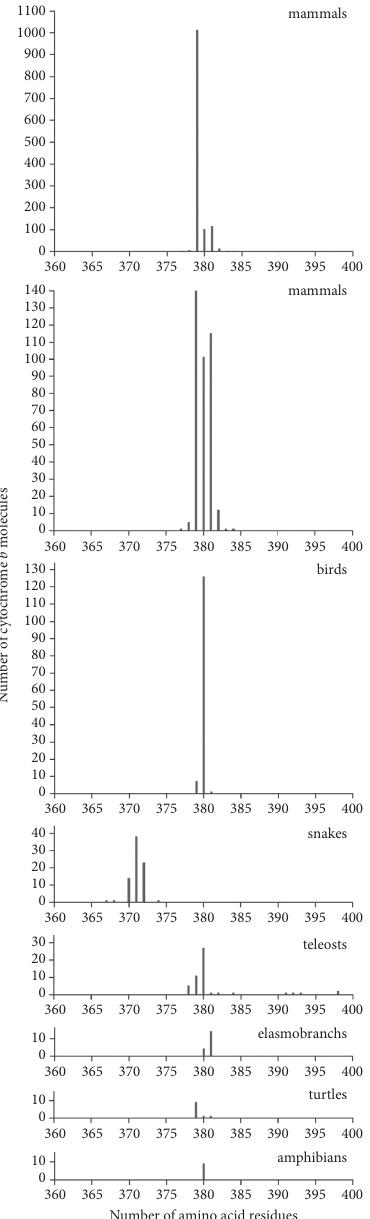
Figure 5: Distribution of the number of cytochrome b molecules, according to data from the Swiss-Prot database on the number of amino acid residues in various biological classes. The data for mammals are presented at two scales of the ordinate—a truncated one, revealing small peaks throughout the entire region where lengths of amino acid residues exist, and a full one, where the entire maximum peak of the distribution is